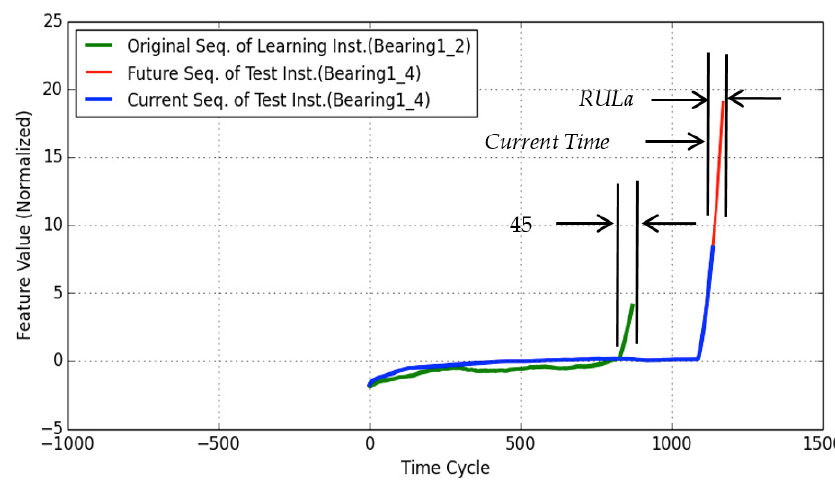
Figure 11. Similarity evaluation for RUL estimation of Bearing1-4 using Bearing1-2.